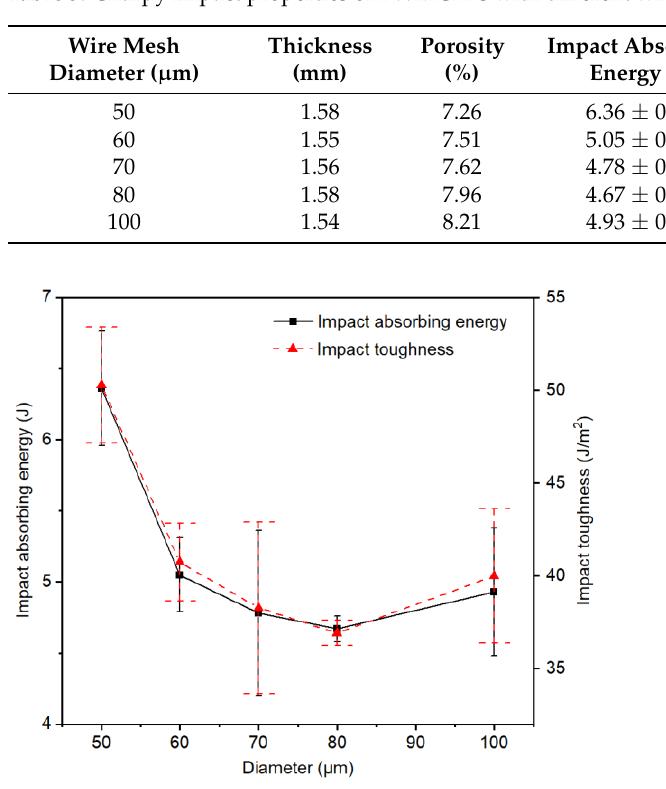
Table 3. Charpy impact properties of PWMCPPs with different wire mesh diameters.